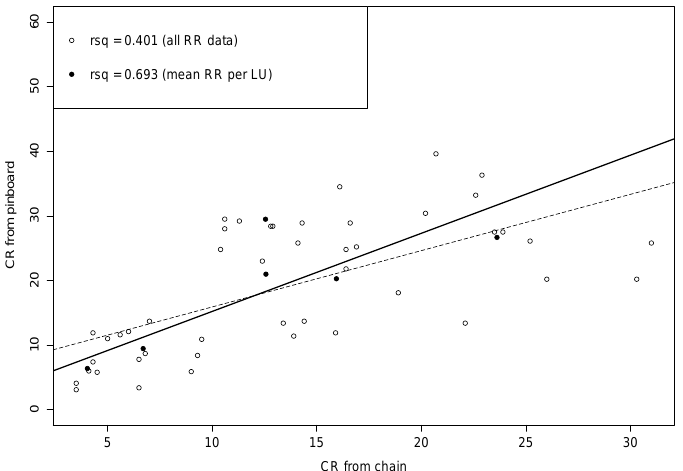
Figure A1. Linear regression between the Cr index measured with the roller chain and the pinboard. The dashed line shows the regression using all the RR data, whereas the solid line shows the regression using one mean RR value per land use. Using the mean RR values yields a higher R 2 value than using all the RR data, as can be seen in the box (upper left corner).